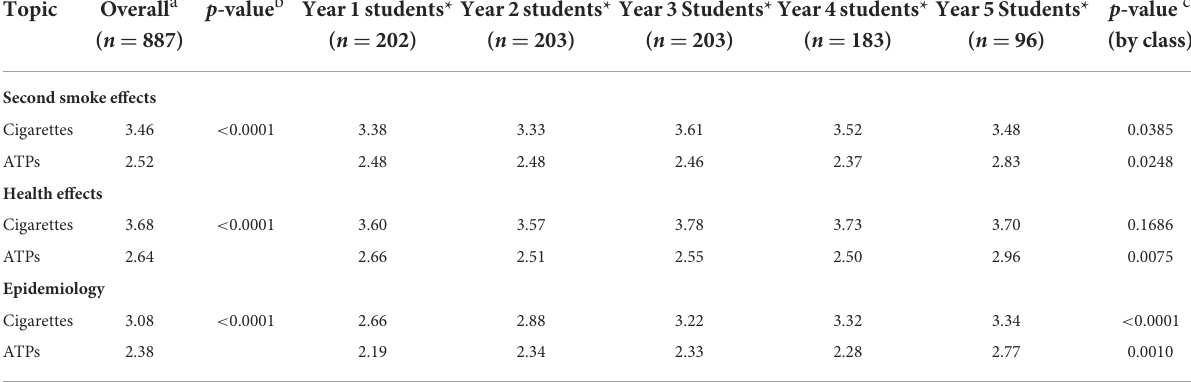
TABLE 4 Clinical medical students’ self-reported level of education about ATPs and traditional cigarettes.